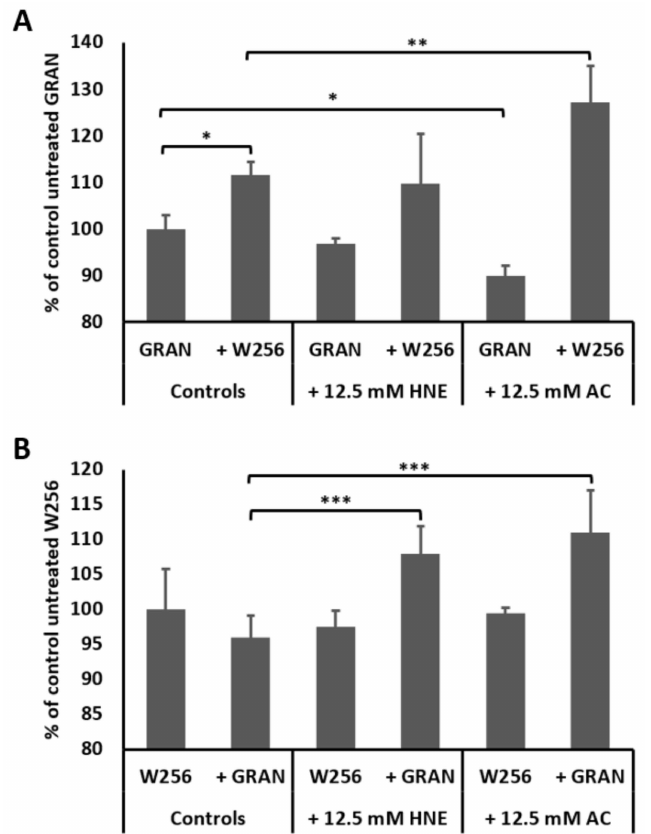
Figure 1. Intracellular ROS production in granulocytes ( A ) and in W256 tumor cells ( B ). Mean values ± SD are given, (*) significance p < 0.05 compared to untreated granulocytes, (**) significance p < 0.01 compared to co-culture of granulocytes and W256 tumor cells and (***) significance p < 0.05 compared to co-culture of granulocytes and W256 tumor